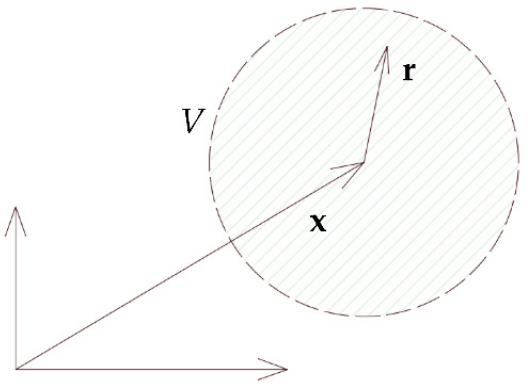
Figure 1. Schematic of the averaging volume along with the vectors x and r . There are, however, certain rules that need to be followed in choosing the appropriate averaging time interval. These are: (1) the averaging time interval must be much